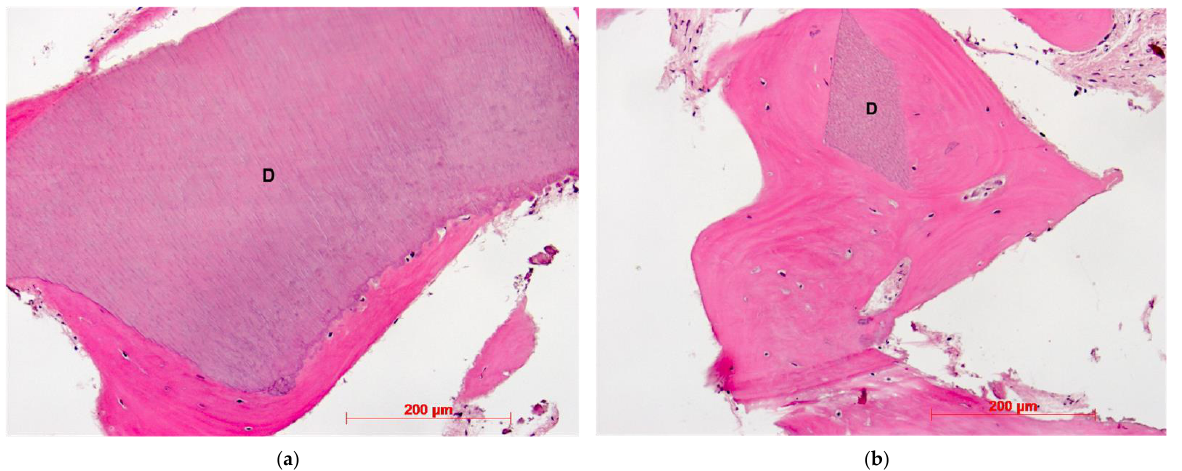
Figure 13. ( a ): Patient 7 — Early-stage osteogenesis around dentin granule (D), HE, original magni- fication ×20. ( b ): Patient 7 — Dentin granule (D) remnant embedded into newly formed bone, HE, original magnification ×20.